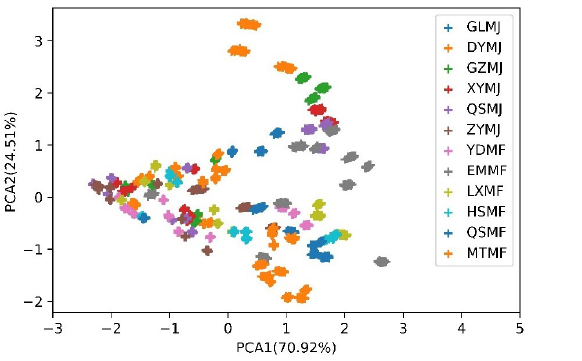
Figure 10. Projection of the first two principal components of the PCA of the tea